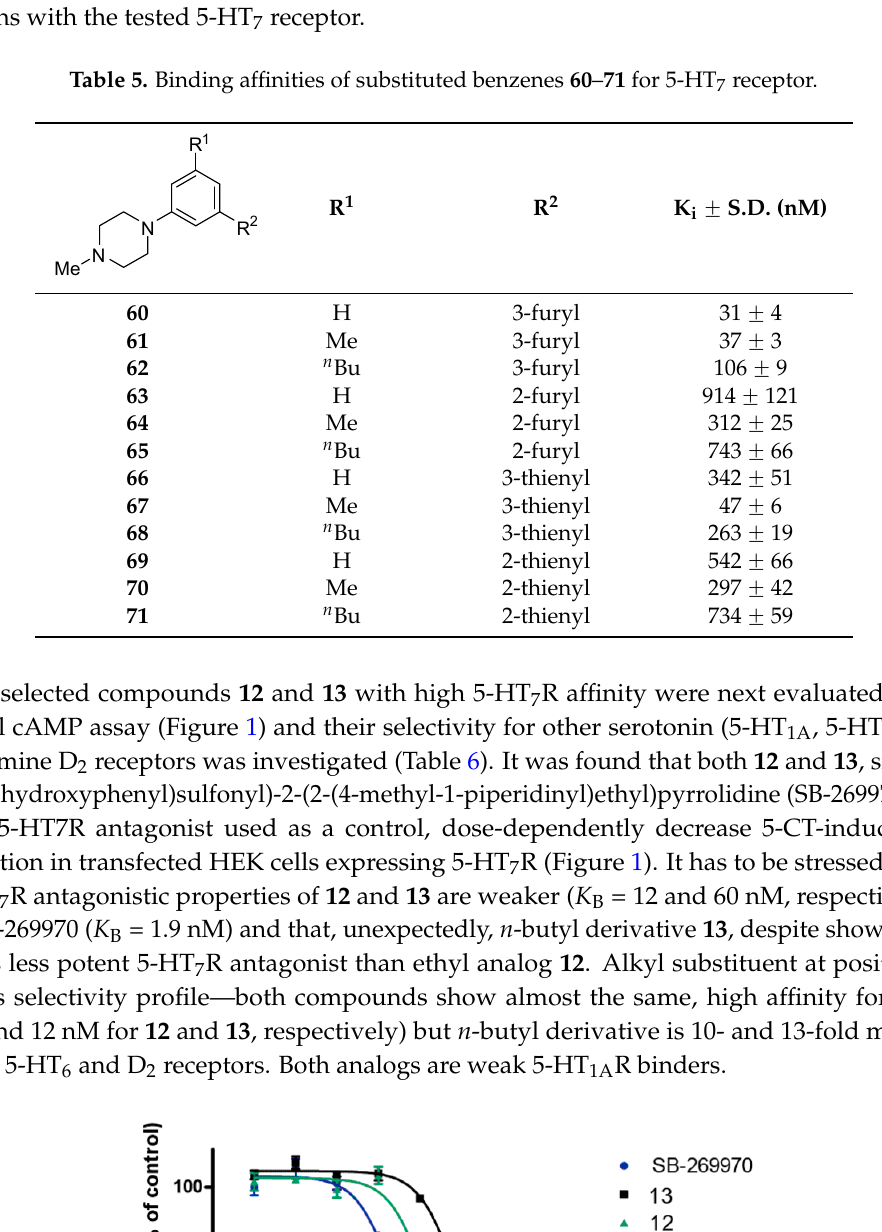
Table 5. Binding affinities of substituted benzenes 60 – 71 for 5-HT 7 receptor.